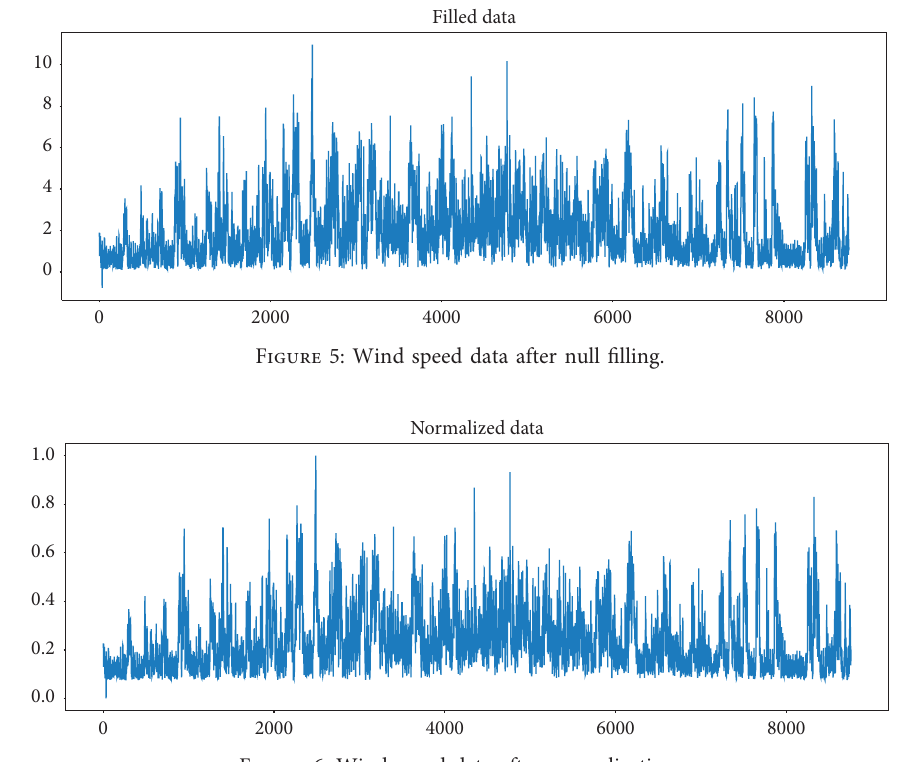
Figure 6: Wind speed data after